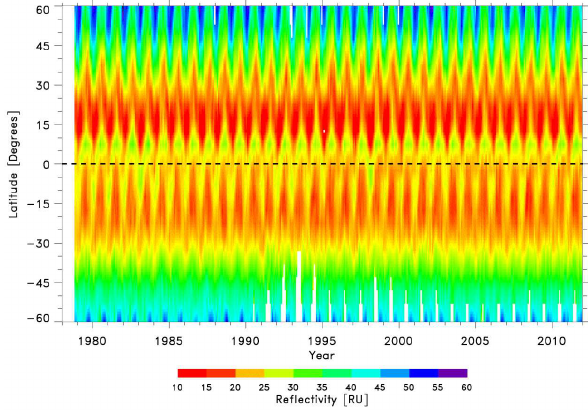
Fig. 4. Zonal mean monthly averages of LER 1979–2011 for all latitudes between 60 ◦ S and 60 ◦ N showing the seasonal patterns as a function of latitude. White is missing